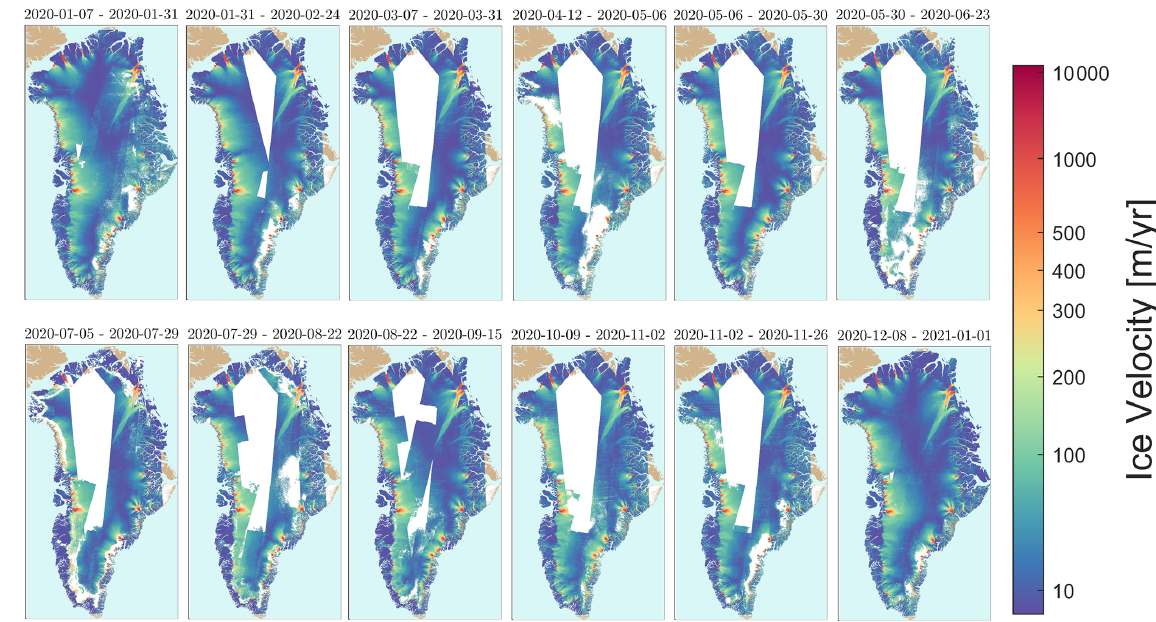
Figure 1. Examples of the PROMICE Ice Velocity maps from 2020: from top left corner to lower right approximately one map per month over 2020. Table 1. Variables in the PROMICE Ice Velocity NetCDF